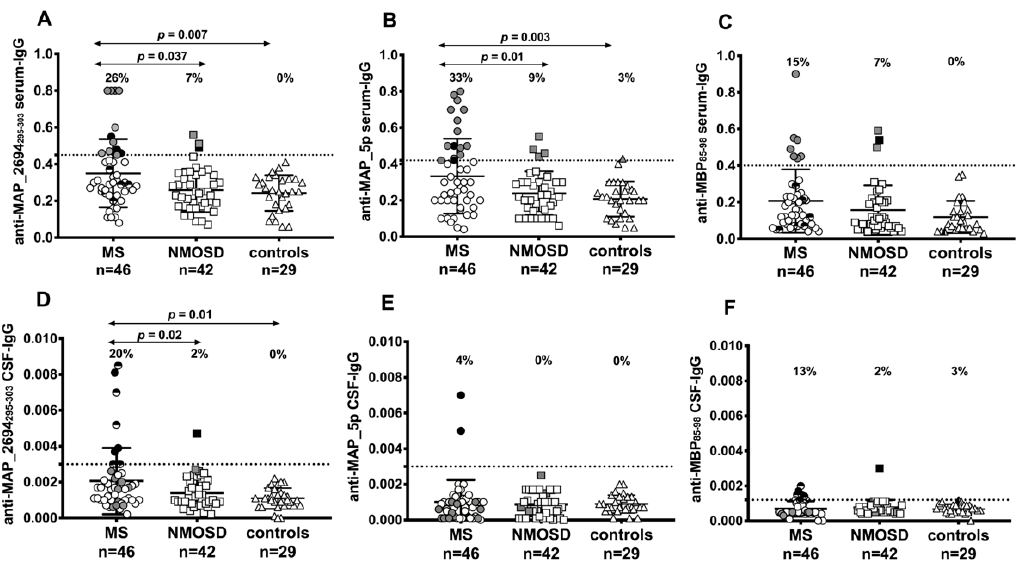
Figure 1. Detection rates for MAP_2694 295–303 , MAP_5p, and MBP 85–98 IgG antibodies in matched serum ( A – C ) and cerebrospinal fluid (CSF) ( D – F ) samples by using indirect ELISA. The percent fraction of antibody-positive sera is indicated on the top of each distribution. Black symbols represent patients with antibodies in both serum and CSF while grey and half-black symbols represent patients with specific antibodies only in the serum or in the CSF, respectively. The horizontal bars represent the mean with a standard deviation while dashed lines indicated cut-off values for positivity calculated by ROC analysis. The p -values, significant if <0.05, are indicated by two-headed arrows.